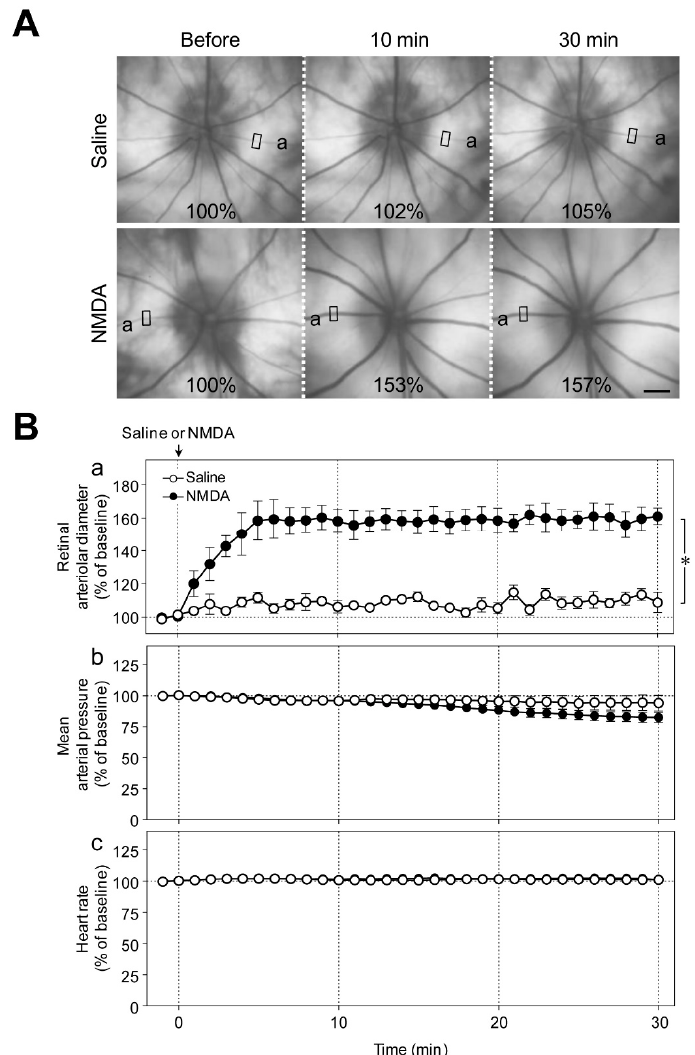
Figure 1. E ff ects of intravitreal injection of NMDA on retinal blood vessels in rats. ( A ) Representative fundus images before, and 10 and 30 min after intravitreal injection of saline and NMDA (6 nmol). Values indicate the diameter of the retinal arteriole in the selected region expressed as a percentage of the baseline value. Scale bar: 500 µ m. ( B ) Changes in ( a ) the retinal arteriolar diameter, ( b ) mean arterial pressure, and ( c ) heart rate induced by intravitreal injection of saline or NMDA. Each point with a vertical bar represents the mean ± SE from five animals. * p <